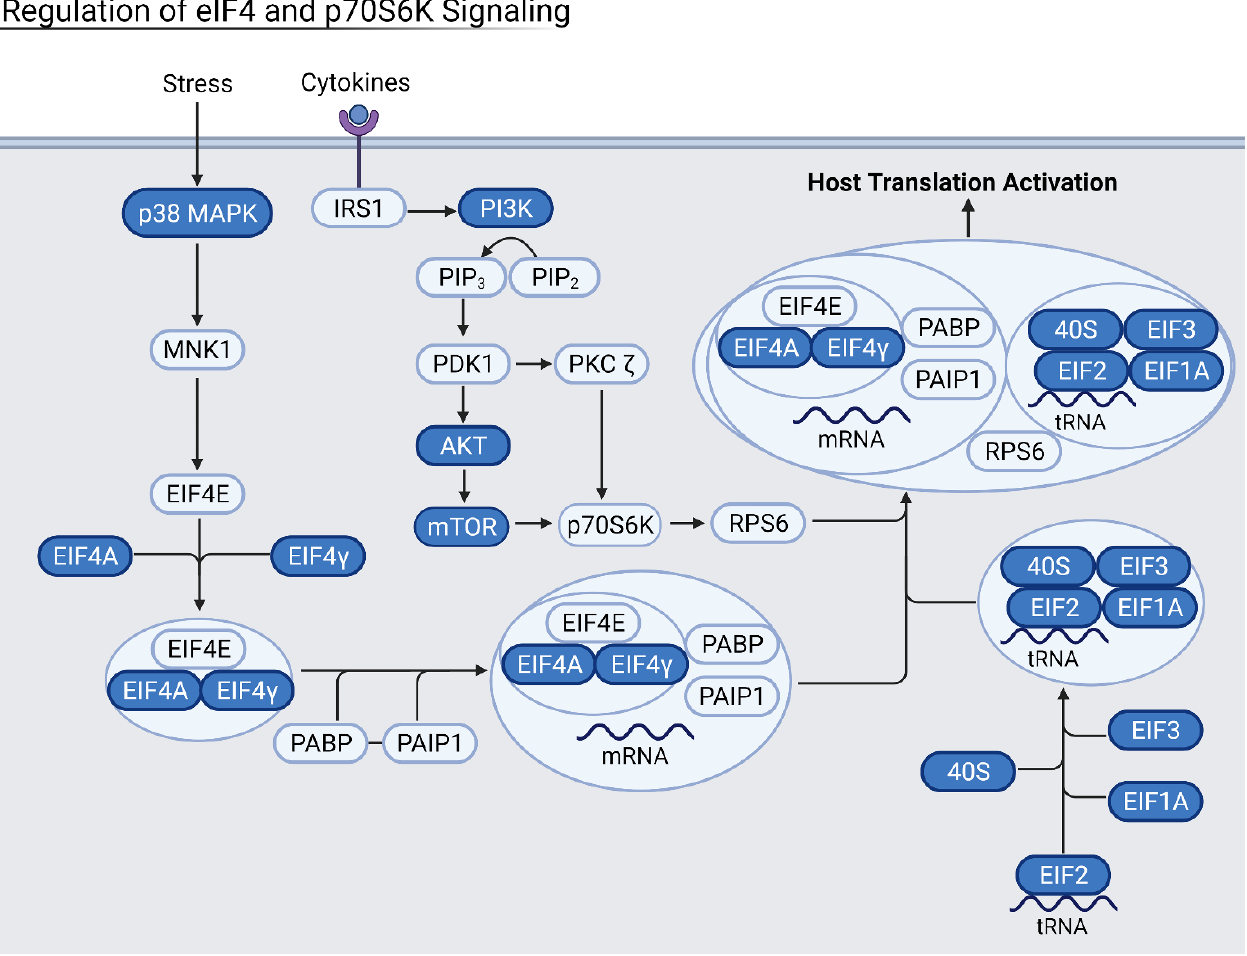
Figure 6. Summary of the eIF4 pathway where blue proteins are downregulated. Samples from severely infected heart, kidney, and liver shared these common downregulated factors. The eIF4 and eIF2 pathways work together to activate and enhance host translation, and their inhibition leads to increased viral translation. Generated in Biorender.